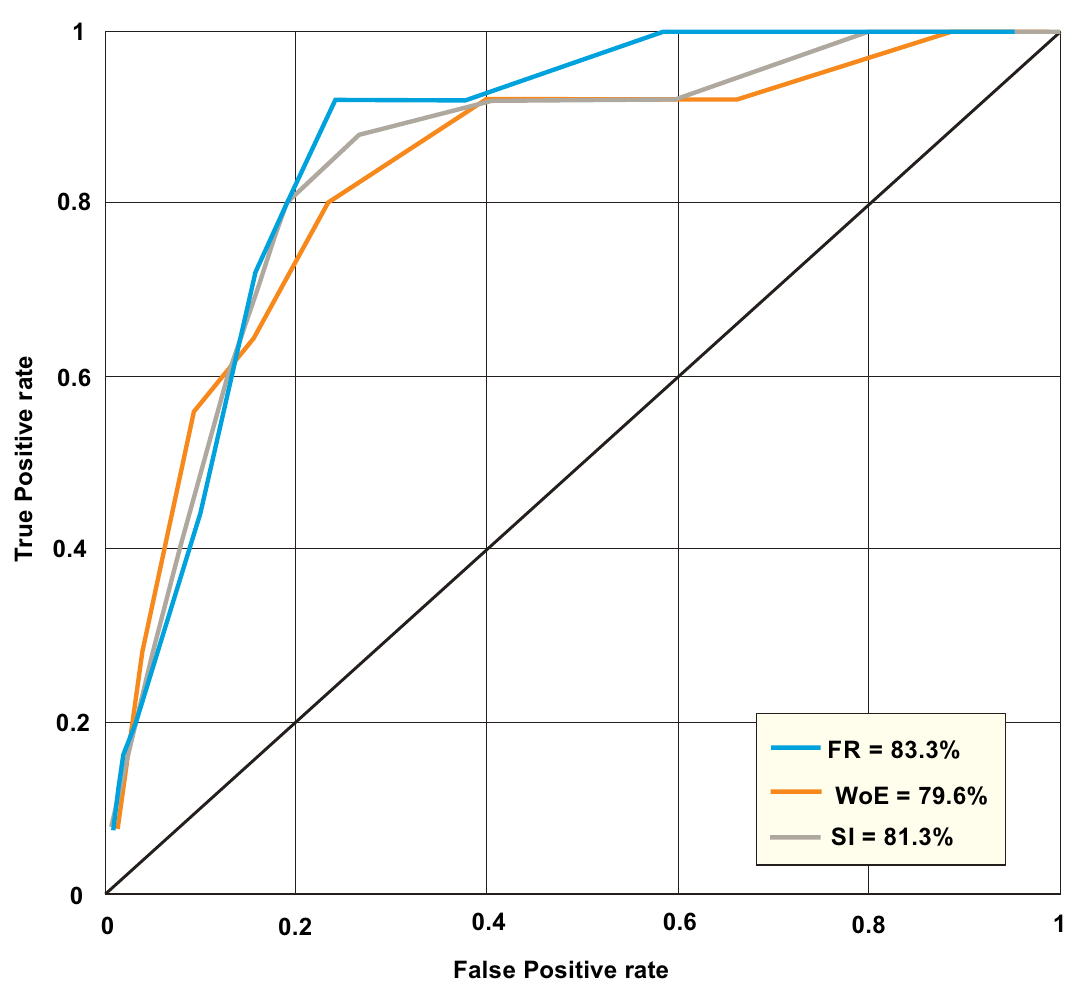
Figure 8. Statistical validation for geothermal predictive